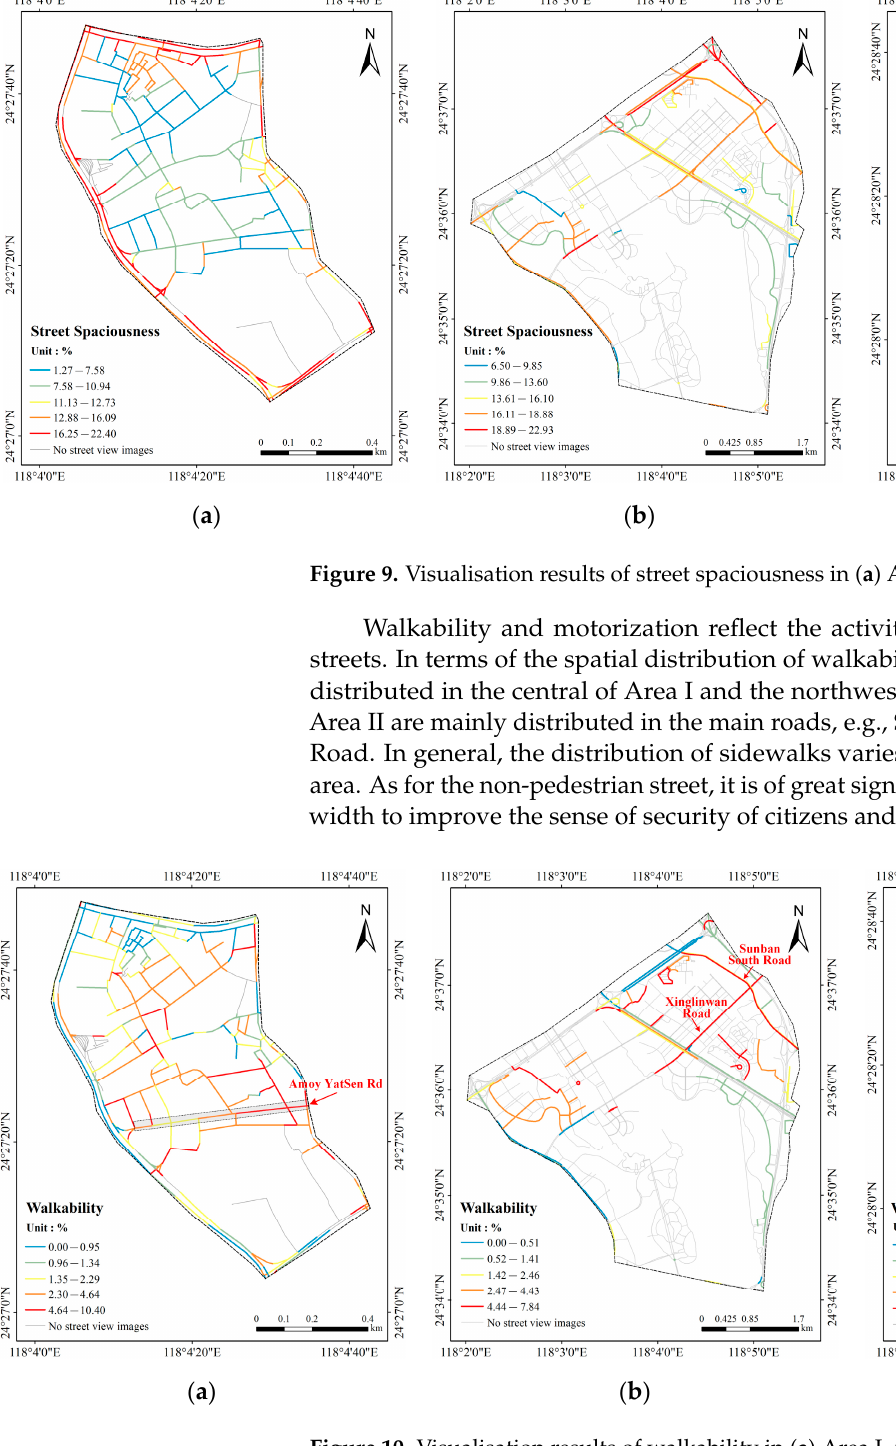
( c ) Figure 11. Visualisation results of motorization in ( a ) Area Ⅰ , ( b ) Area Ⅱ , and ( c ) Area Ⅲ . 4.2. Results Analysis of Urban Street Vitality The spatial visualisation analysis of the comments data was conducted using the Ker- nel Density tool in ArcGIS [36]. The results are shown in Figure 12. Siming district is at the center of Xiamen and has rapid economic development and densely distributed infra- structure. Amoy Yat-Sen Rd is one of Xiamen’s most prosperous commercial streets, with daily passenger counts above 300,000 on weekends [40]. Figure 12a shows that the spatial distribution of the location of comment data in Area Ⅰ and Area Ⅲ of Siming District is widely distributed. In contrast, the spatial distribution of the location of comment data in Area Ⅱ (Jimei District) is more scattered. As shown in Figure 12b, the density of the